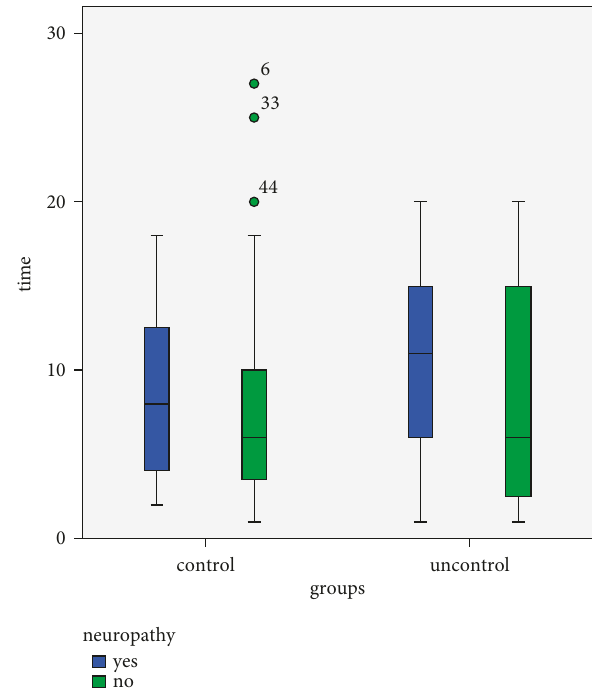
Figure 3: Relationship between duration of diabetes and neu- ropathy based on